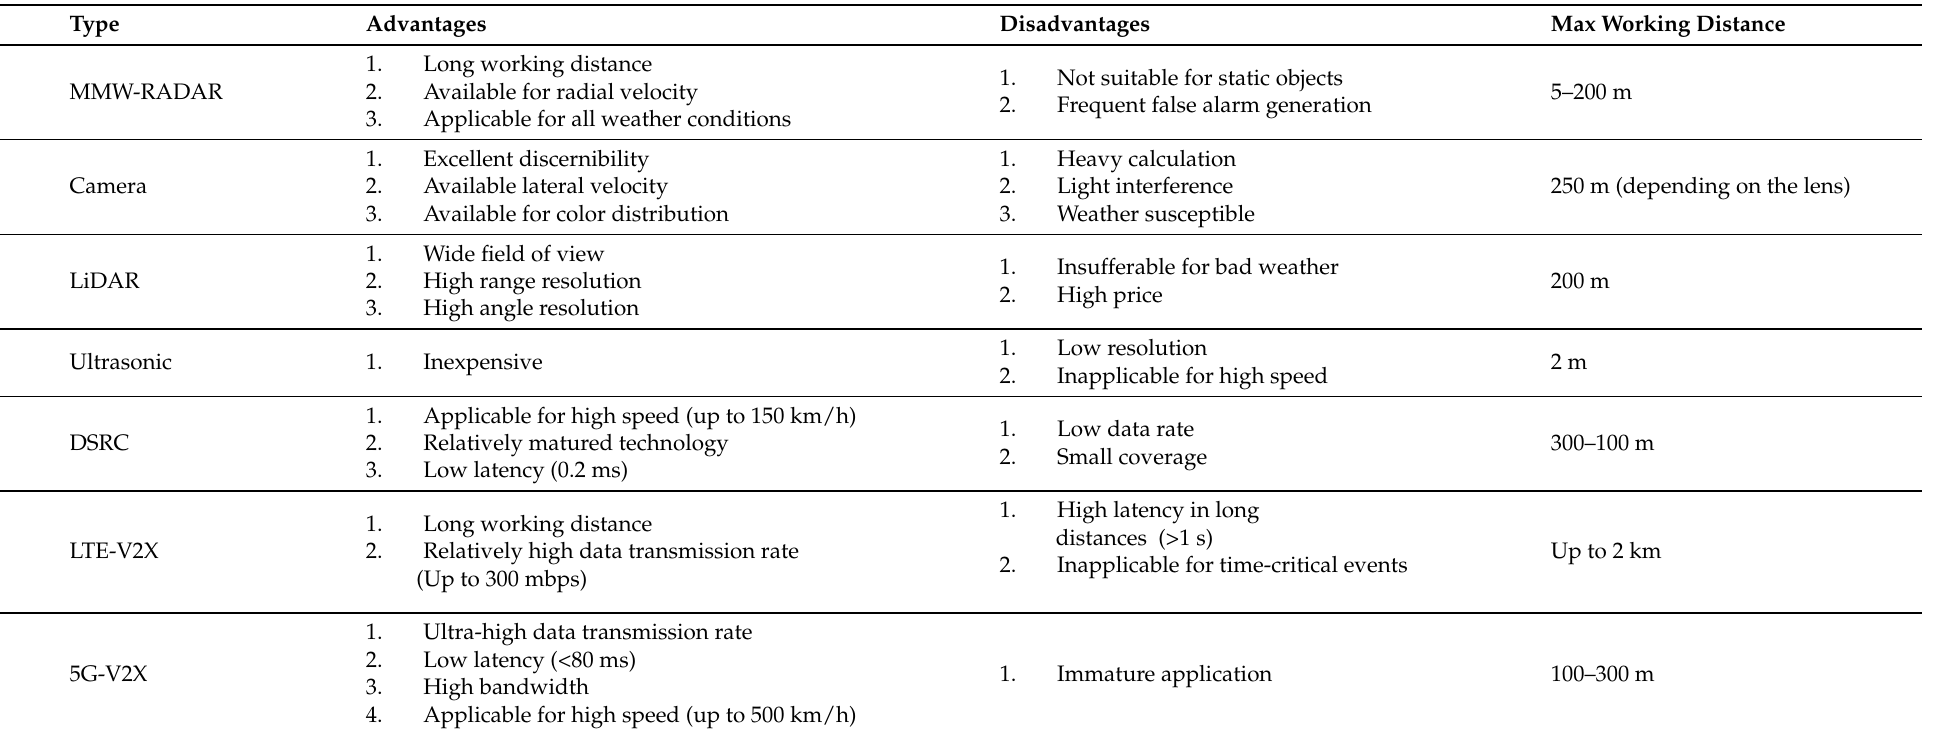
Table 2. Comparison of the different sensory